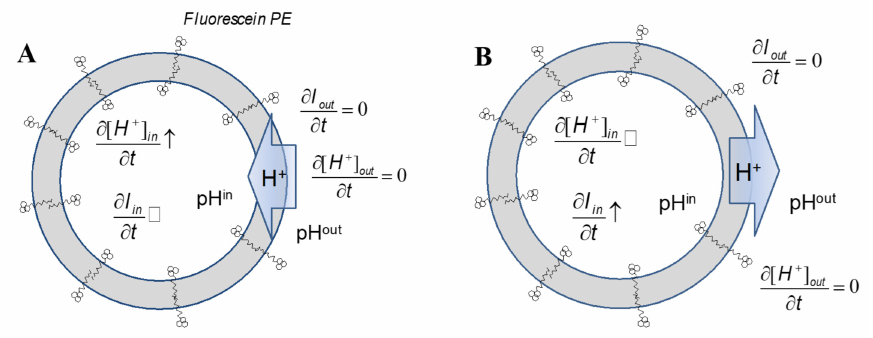
Figure 10. The drawing demonstrates an experimental design for proton transfer measurements using fluorescein-PE. In general, higher proton inner concentration (lower pH—panel B ) will result in proton efflux and the decrease of the fluorescein intensity, while the lower proton inner concentration (higher pH—panel A ) outcomes with the fluorescence